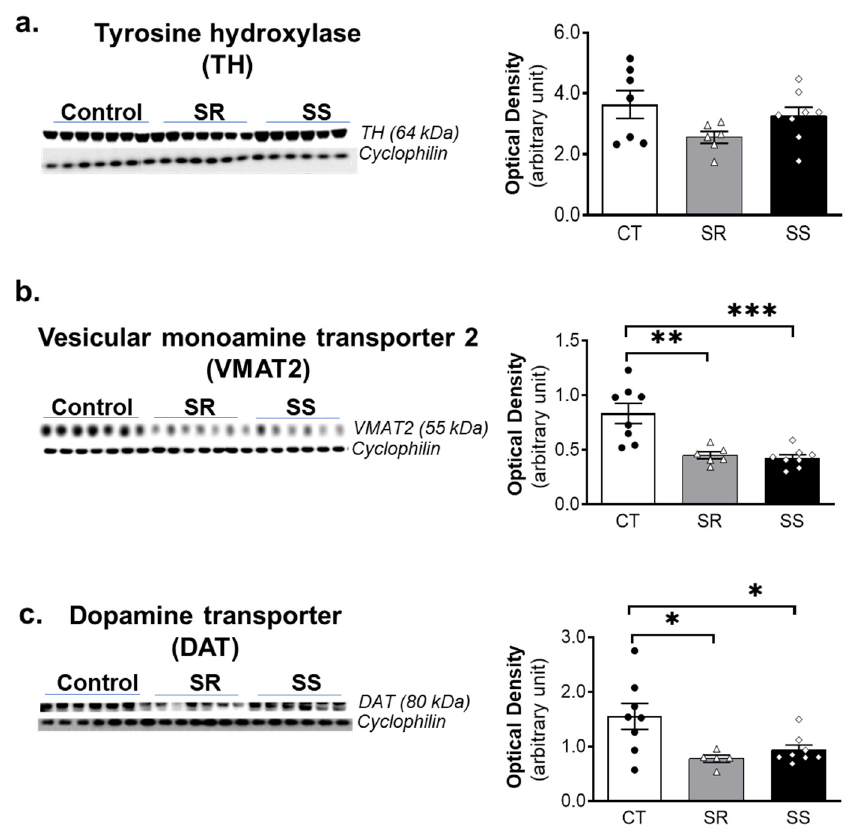
Figure 5 . METH SA is associated with decreased VMAT2 and DAT protein levels in the dorsal striatum of both SR and SS rats. Protein levels of TH ( a ), VMAT2 ( b ) and DAT ( c ) were determined by Western blot analyses. The left panel shows the immunoblot images, and the right panel shows the quantitative measures. For quantification, the protein levels of TH, VMAT2 and DAT were normalized to cyclophilin and then analyzed. All values represent means ± SEM (n = 6–7 rats per group). Key to statistics: * p < 0.05, ** p < 0.01, *** p < 0.001, comparison to control saline group. The statistical analysis was performed using one-way ANOVA and Tukey’s post hoc